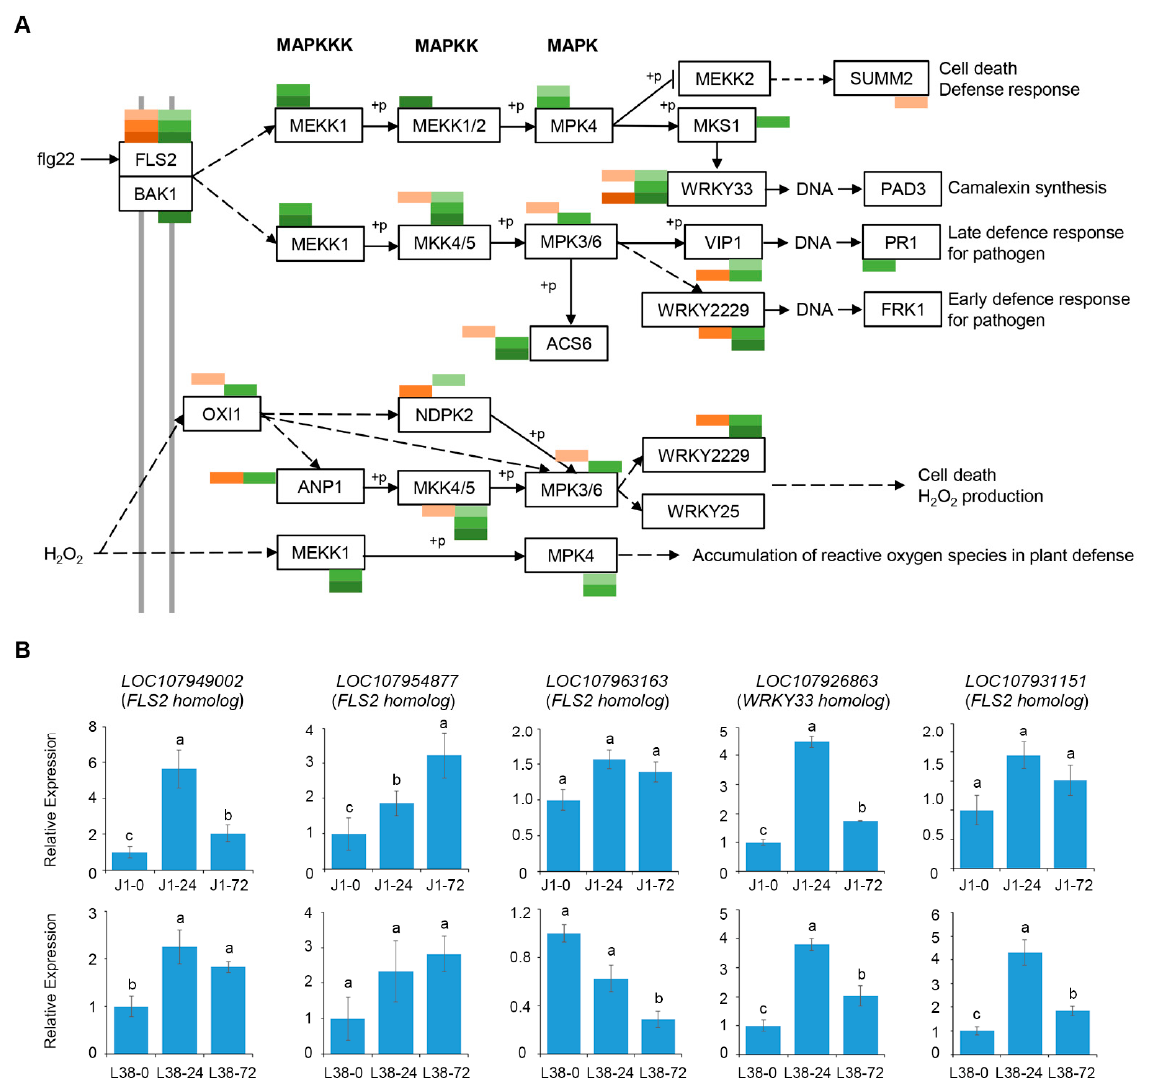
Figure 6. DEGs were enriched in MAPK signaling pathway. ( A ) Demonstration of enrichment of DEGs in MAPK signaling pathway with p -value < 0.05. ( B ) Expression pattern analysis of specific DEGs of J1 and L38 assigned in MAPK signaling pathway by RT-qPCR. Relative expression levels were normalized by cotton 18S expression level. The relative gene expression level in J1-0 and L38-0 were assigned a value of 1. Error bars indicate ±SD of three biological replicates, with each measured in triplicate. Samples marked with different letters show a significant difference at p < 0.05 by Duncan’s multiple range test.